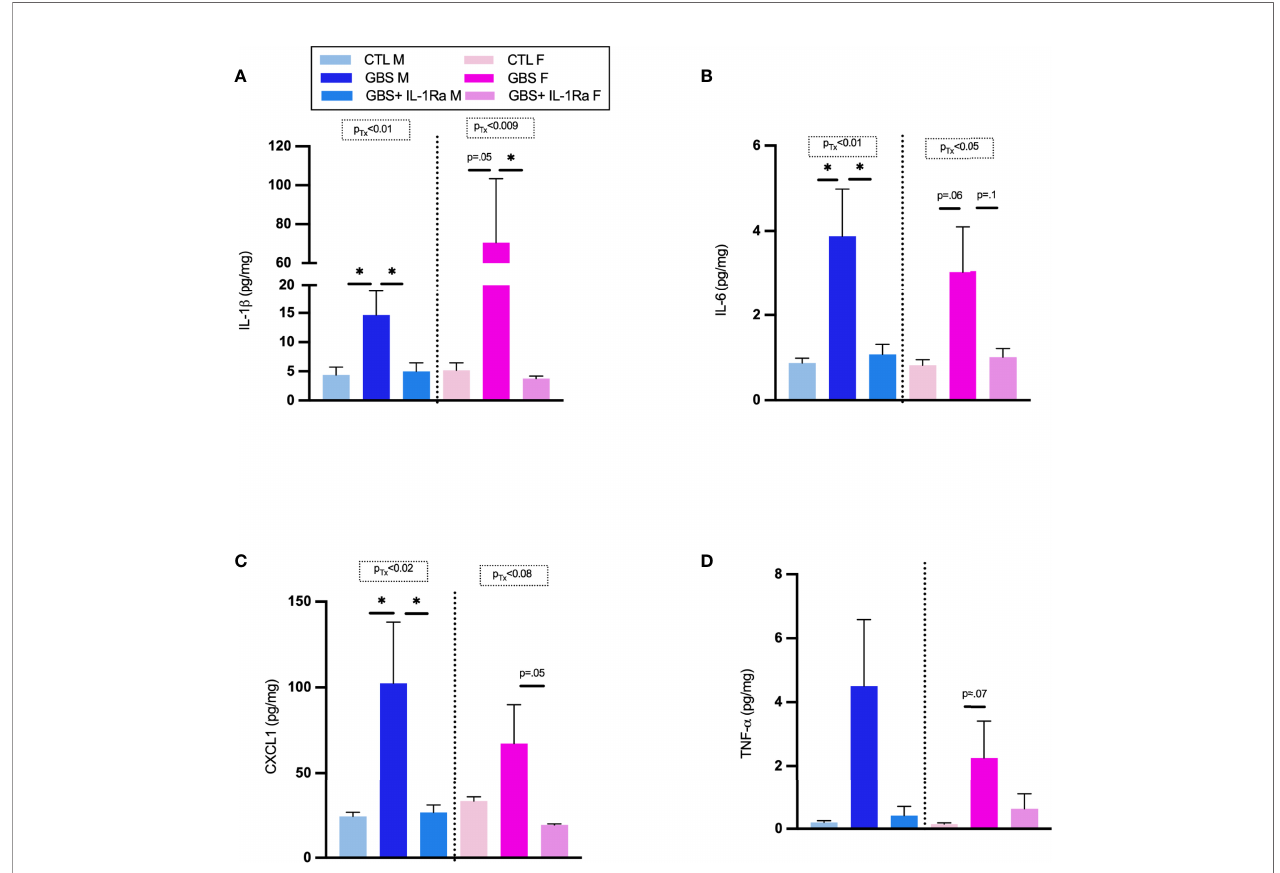
FIGURE 2 | Administration of IL-1Ra to the dam decreased the levels of pro-in fl ammatory cytokines within GBS-infected placentas. Mean concentration of IL-1 b (A) , IL-6 (B) , CXCL1 (C) , and TNF- a (D) in placentas at 72 h quanti fi ed by ELISA. Data were collected from four individual experiments. Statistical analyses were done by one-way ANOVA or Kruskal-Wallis test with Dunnett ’ s or Dunn ’ s multiple comparisons multiple between the experimental groups (CTL, GBS, and GBS plus IL-1Ra); * p < 0.05. Bars show mean ± SEM. Number (n) of male and female placentas: CTL (male and female, n = 3-6), GBS (male and female, n = 4-7), and GBS plus IL-1Ra, (male and female, n = 6-7). CXCL1, chemokine (C-X-C motif) ligand 1; ELISA, enzyme-linked immunosorbent assay; F, female; GBS, group B Streptococcus ; IL, interleukin; IL-1Ra, IL-1 receptor antagonist; M, male; SEM, standard error of the mean; Tx,